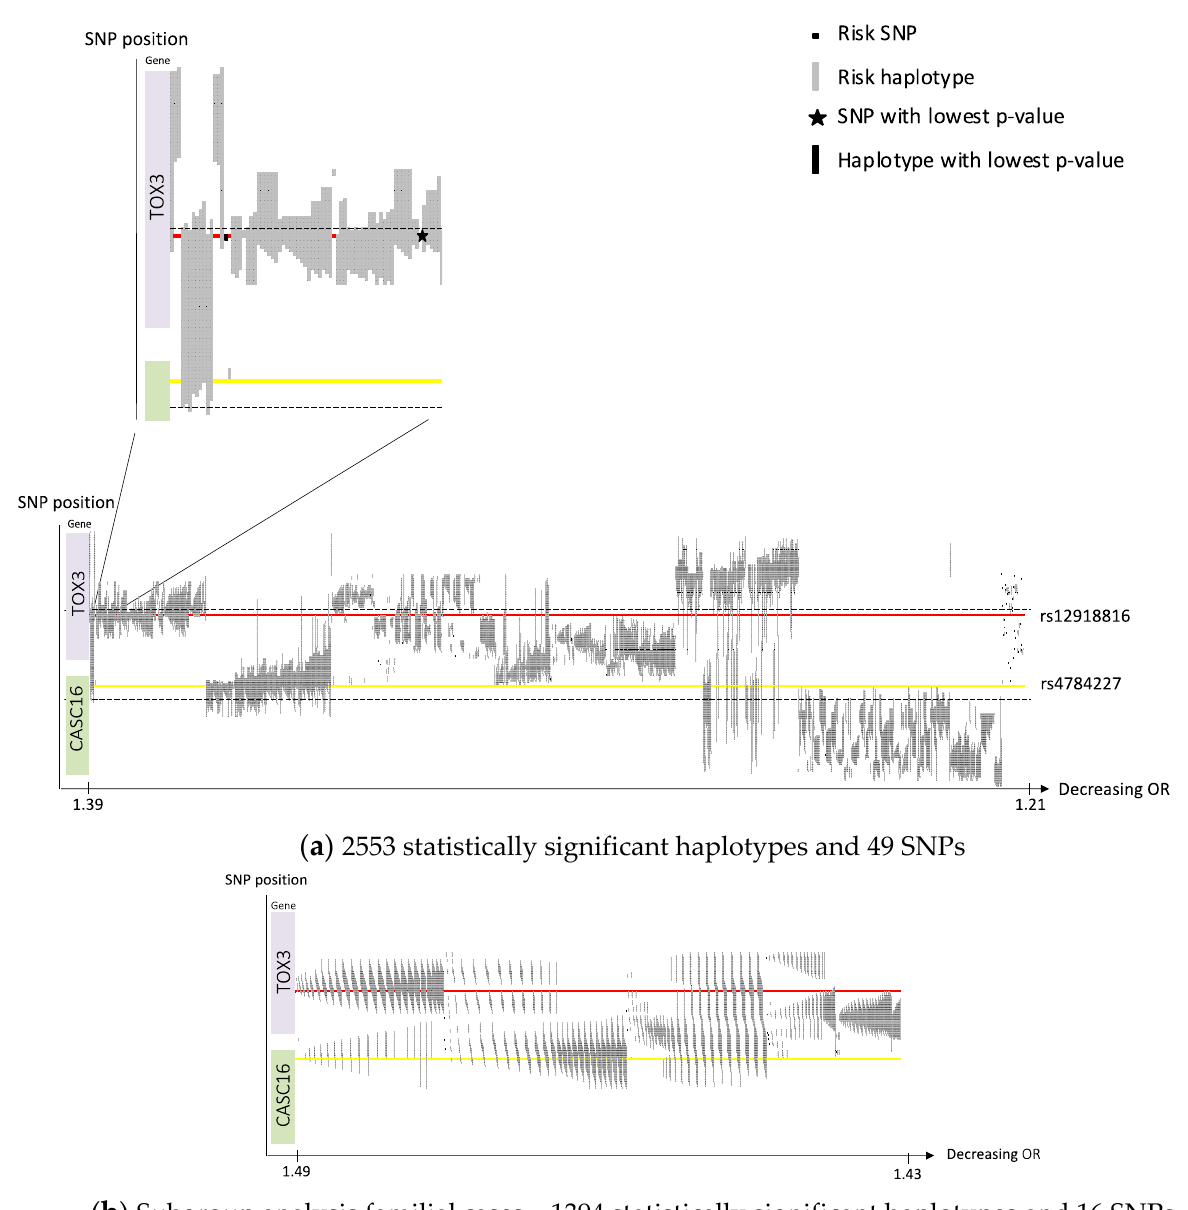
Figure 3. Chromosome 16, haplotypes and SNPs sorted on OR. ( a ) SNP position on the y -axis. Gene position for FGFR2 is indicated along the y -axis. Corresponding OR on the x -axis. The red line indicates the position of the SNP with the lowest p -value. The yellow line indicates the position of one published BCAC SNP within the area. The dashed lines indicate the position of the proximal and distal SNP of the significant haplotype of window 50 with the lowest p -value; ( b ) axis, red and yellow lines illustrated as in ( a